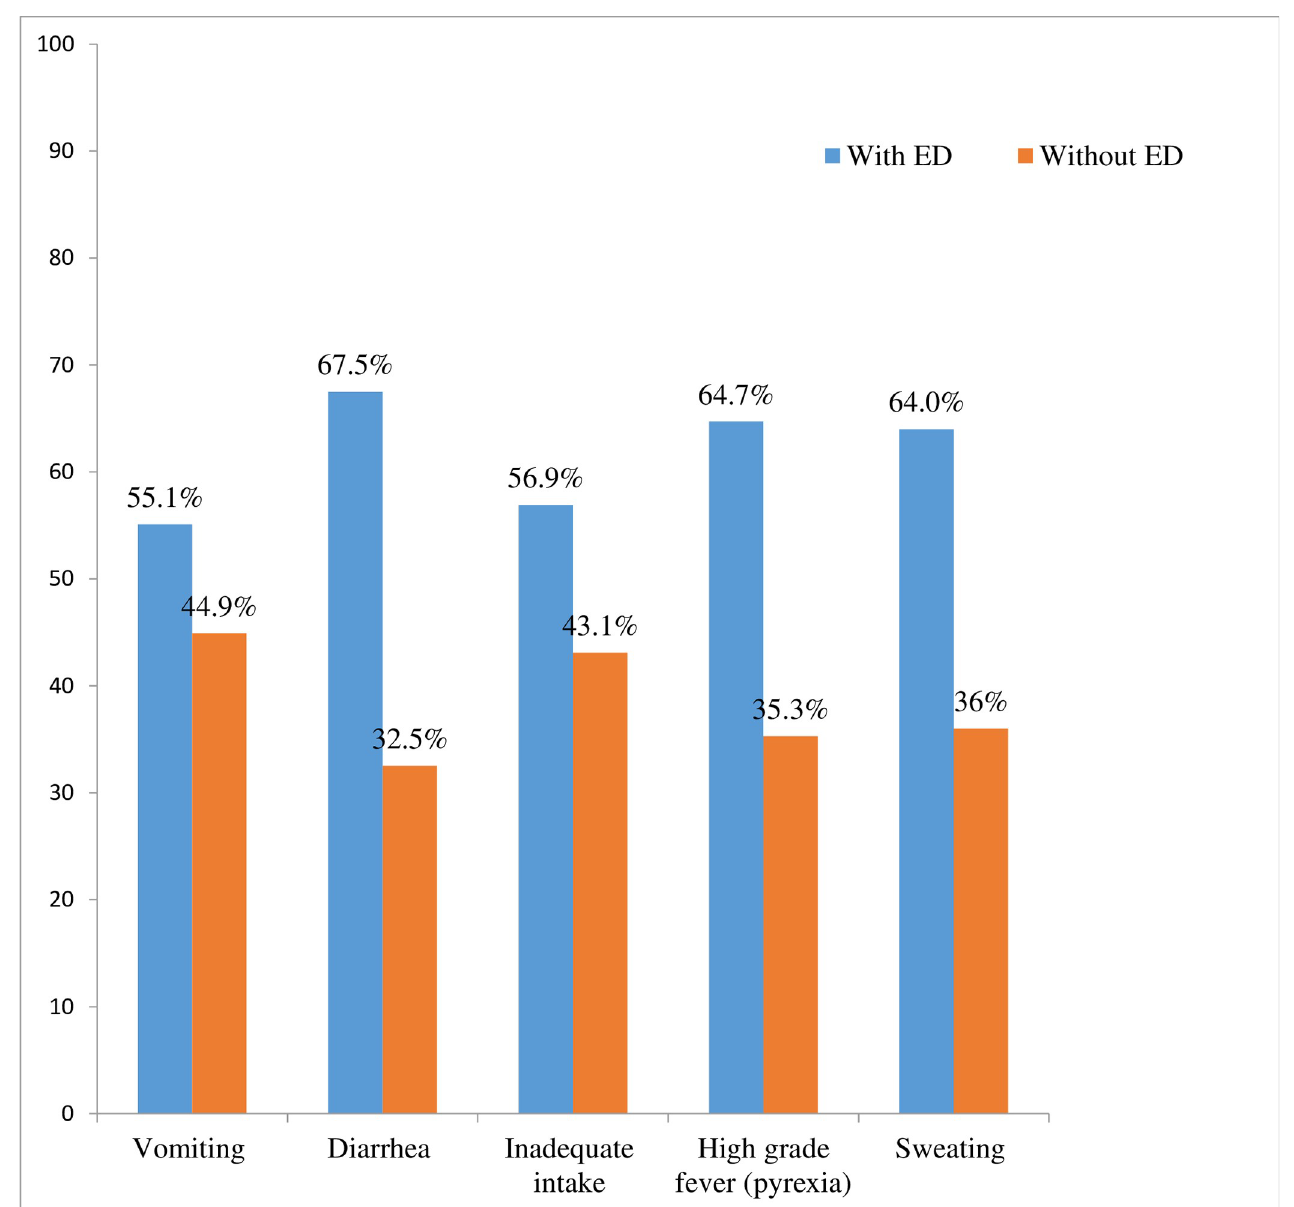
Fig 2. Distribution of known comorbidities precipitating for electrolyte disturbance among patients with and without electrolyte disturbance, in Jimma Medical Center, South west Ethiopia from April-May 2019.